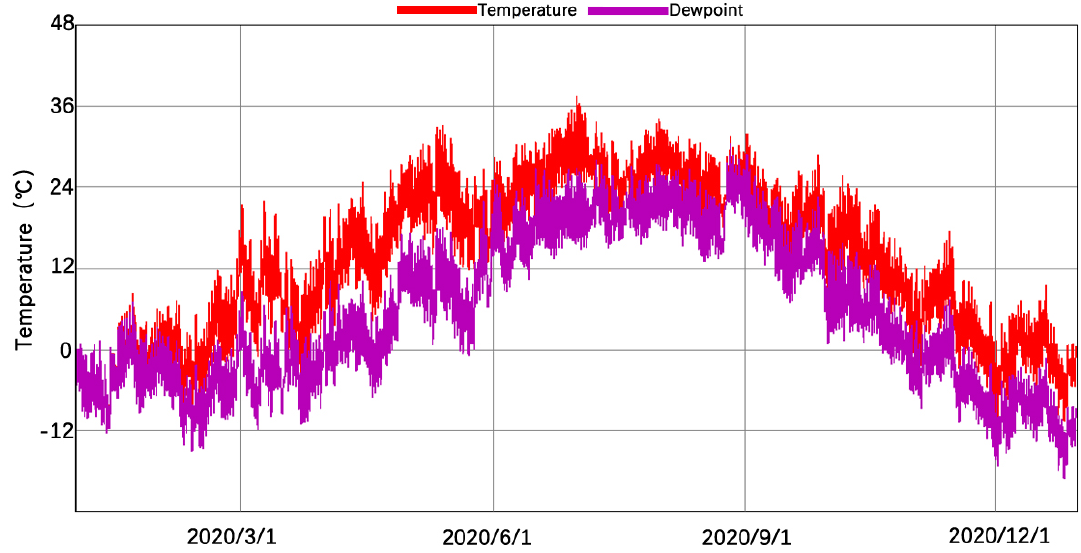
Figure 17. Dewpoint and temperature of monitoring point 2.